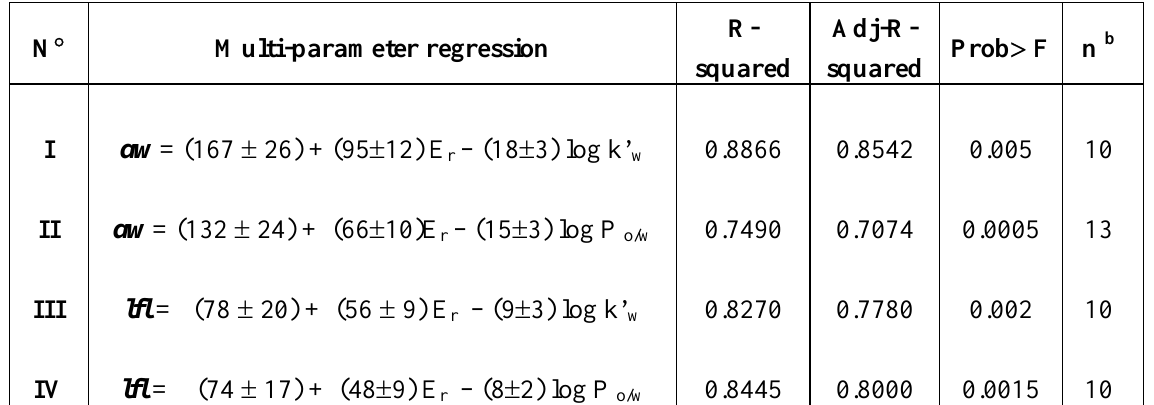
Table 4 : Multi-parameter regressions between the biological indexes and physico- chemical properties of N -oxide